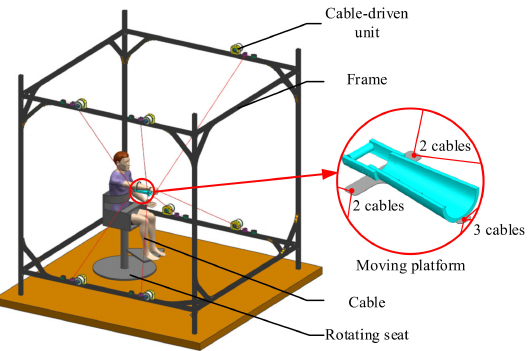
Figure 1. Parallel cable-driven upper limb rehabilitation robot.